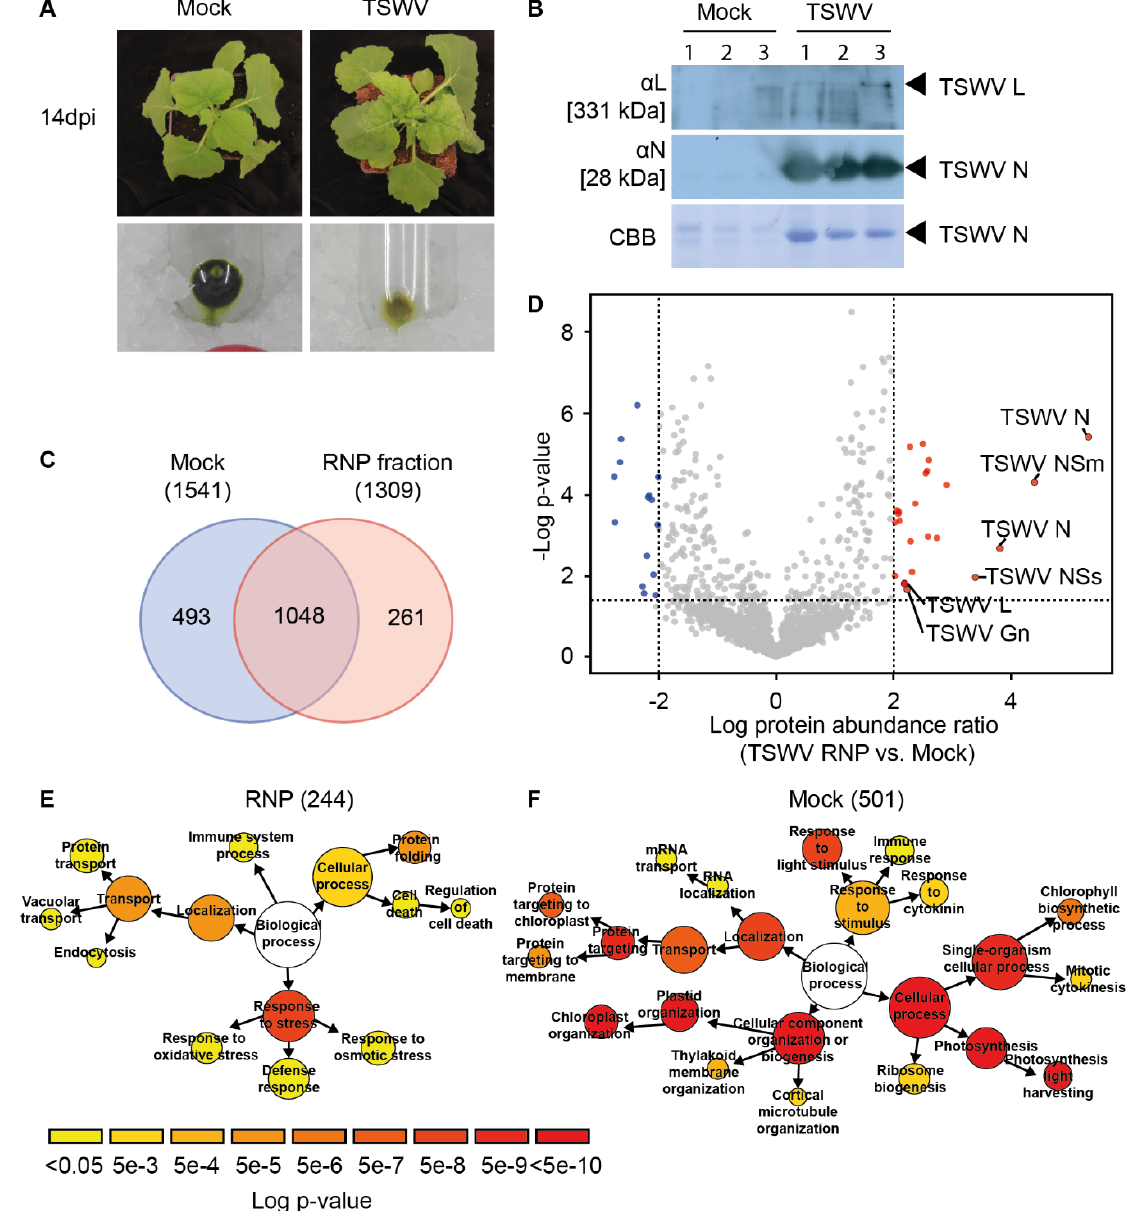
Figure 1. Mass spectrometry analyses of the TSWV RNP-containing fraction from N. benthamiana . ( A ) Ribonucleoprotein (RNP)-containing fractions were purified from TSWV-inoculated N. benthamiana and mock plants at 14 dpi. ( B ) Western blots of the RNP fractions purified from leaf material via density separation. For all three biological replicates of the RNP samples and the mock control samples, the presence of the viral L and N proteins was confirmed. ( C ) Venn diagram showing the overlap in proteins present in the RNP and mock samples. ( D ) Volcano plot of the proteins identified in the RNP samples compared to the mock control. All significant proteins are visualized by blue or red dots. All the viral proteins identified are indicated. ( E ) and ( F ) Gene ontology (GO) enrichment analysis of the plant proteins present in the ( E ) TSWV RNPs or ( F ) mock samples. The number of proteins per GO category is represented by the size of the circles. Scale bar indicates the log 10 p -value cut-off values (hypergeometric enrichment test), with yellow and red indicating low and high level of significance, respectively.